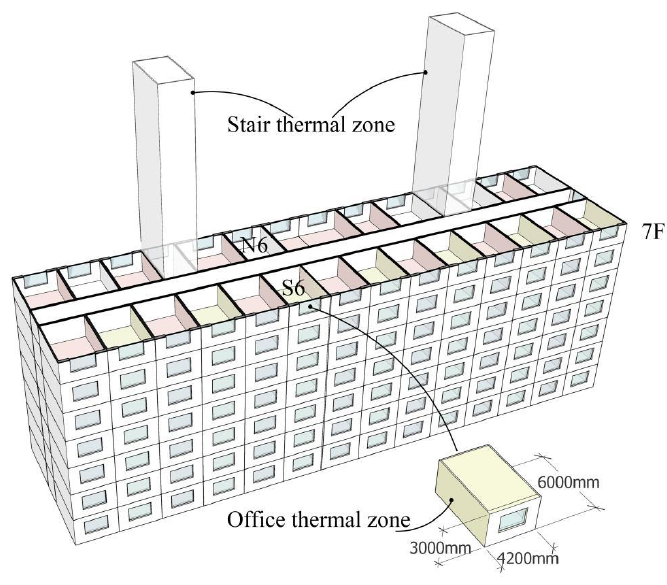
Figure 7. Schematic diagram of building thermal zone. Table 8. The model parameters.